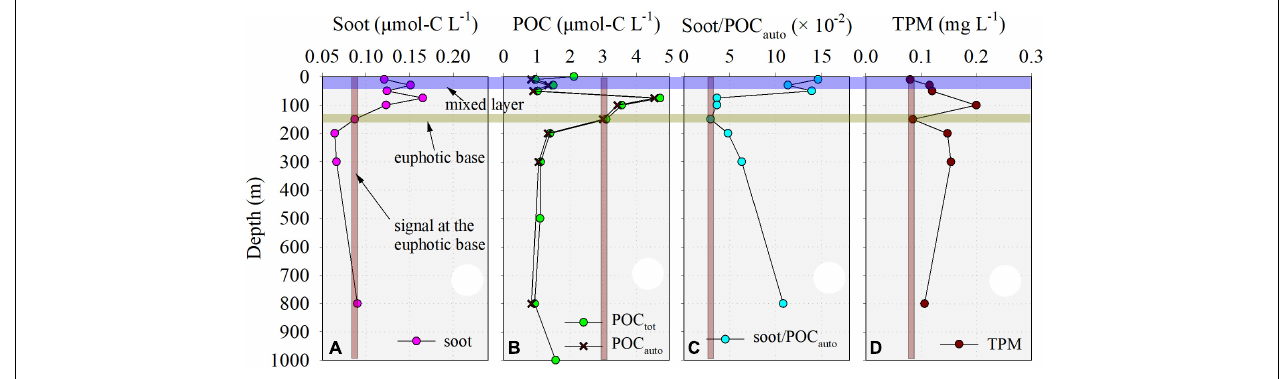
FIGURE 2 | Vertical distributions of soot (A) , total particulate organic carbon (POC) (i.e., POC tot ), autochthonous POC excluding soot (i.e., POC auto ) (B) , soot/POC auto ratio (C) , and total particulate matter (TPM) (D) at station C9 on the slope of the northeastern South China Sea.